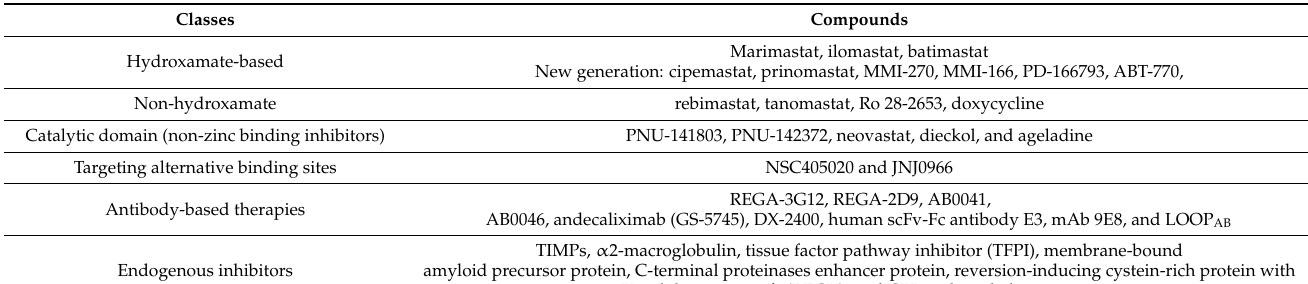
Table 3. Main MMP inhibitor